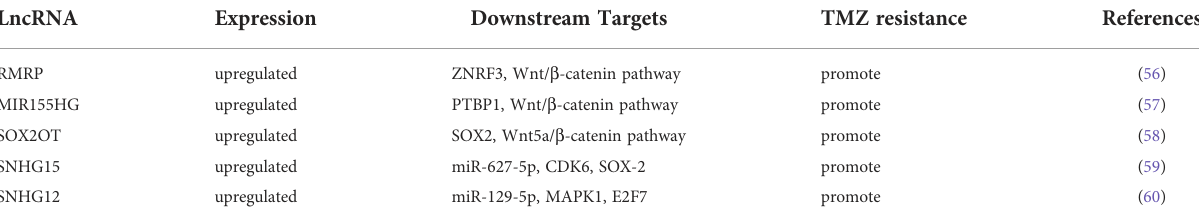
TABLE 4 Representative lncRNAs and related signaling pathways of TMZ resistance.